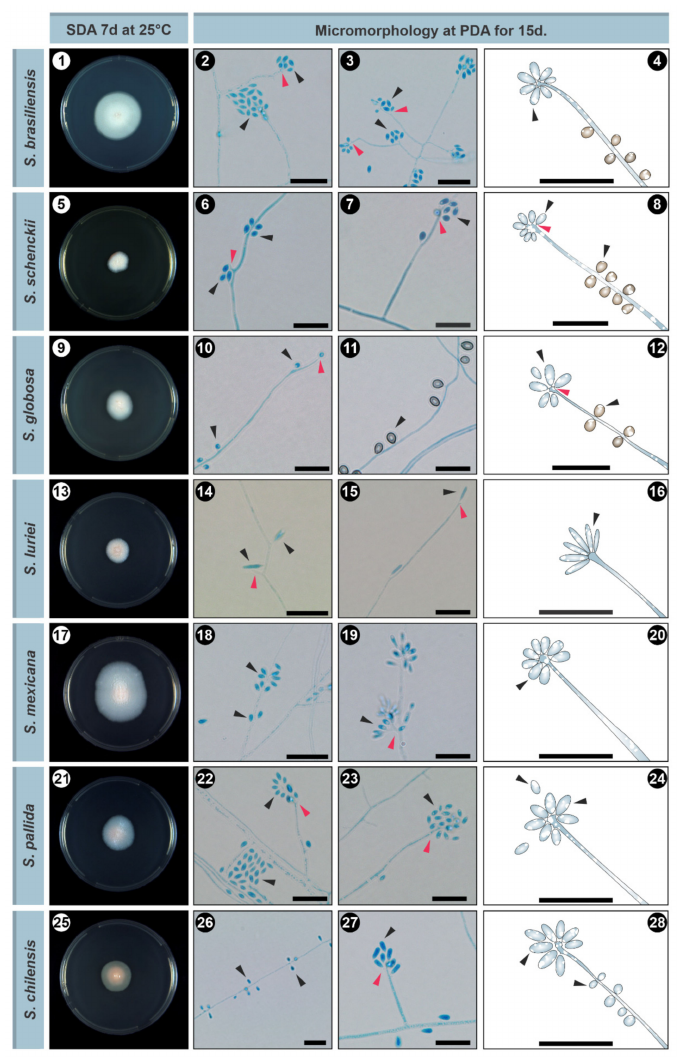
Figure 4. Macromorphological and micromorphological aspects of Sporothrix species. (1) Macro- and (2–4) micromorphology of S. brasiliensis ; (5) Macro- and (6–8) micromorphology of S. schenckii ; (9) Macro- and (10–12) micromorphology of S. globosa ; (13) Macro- and (14–16) micromorphology of S. luriei ; (17) Macro- and (18–20) micromorphology of S. mexicana ; (21) Macro- and (22–24) micromor- phology of S. chilensis ; (25) Macro- and (26–28) micromorphology of S. pallida . Red arrows indicate phialides and black arrows indicate conidia. SDA: Sabouraud dextrose agar. Bar = 10 µ